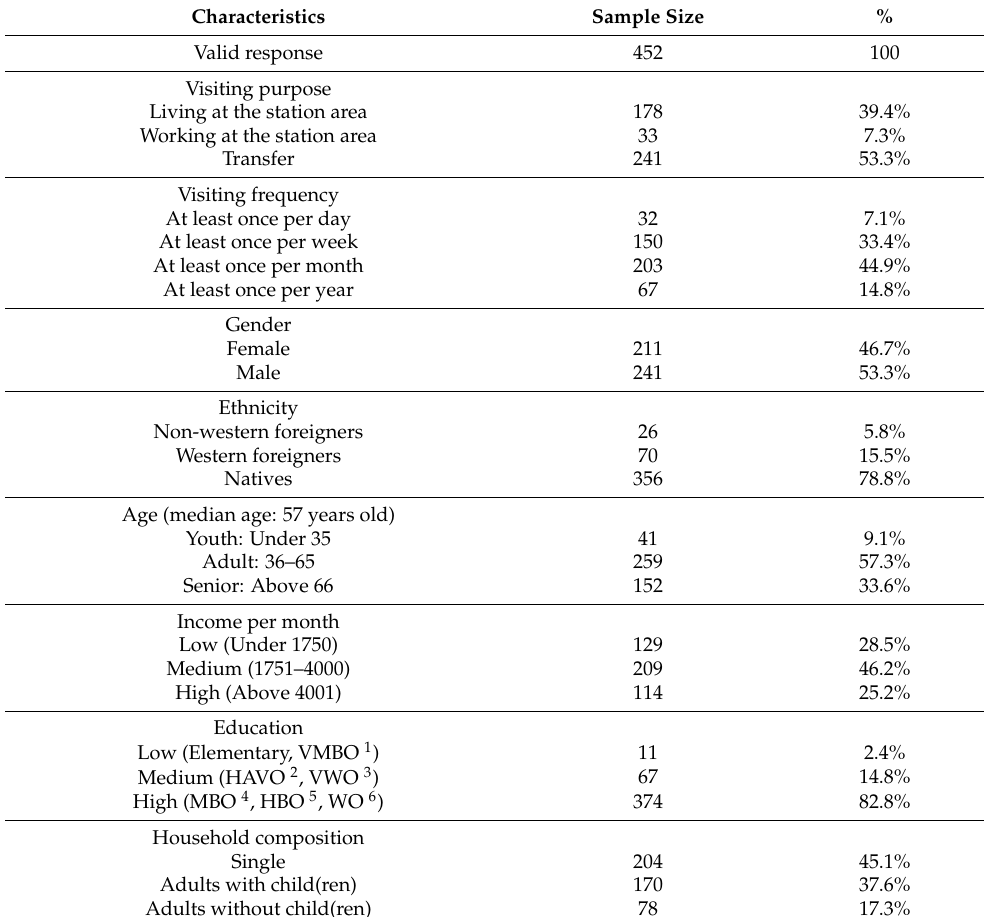
Table 4. Socio-demographic and visiting